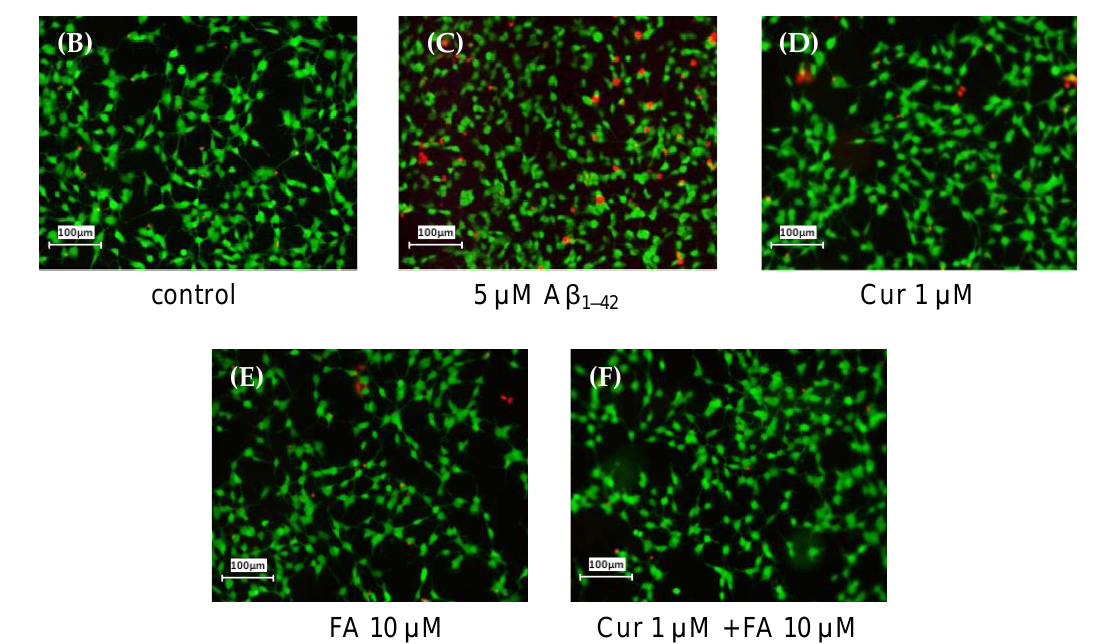
Figure 4. Effect of Cur, FA, or a combination of both on the cytotoxicity in A β 1–42 -stimulated SH-SY5Y cells. The cytotoxicity in A β 1–42 -stimulated SH-SY5Y cells was evaluated using EthD-1 Cell assay. ( A ) The cytotoxicity of SH-SY5Y cells exposed to 5 µ M A β 1–42 and treated with A β 1–42 + 1 µ M Cur, A β 1–42 + 10 µ M FA or A β 1–42 + 1 µ M Cur + FA. ( B – E ) Fluorescence microscopic images in SH-SY5Y cells were acquired using an inverted fluorescence microscope. ( B ) Untreated SH-SY5Y cells; ( C ) SH-SY5Y cells exposed to 5 µ M A β 1–42 ; ( D ) SH-SY5Y cells treated with 5 µ M A β 1–42 + 1 µ M Cur; ( E ) SH-SY5Y cells treated with 5 µ M A β 1–42 + 10 µ M FA; ( F ) SH-SY5Y cells treated with 5 µ M A β 1–42 + 1 µ M Cur + 10 µ M FA. The scale bar represents 100 µ m. +: inclusion of 5 µ M A β 1–42 , 1 µ M Cur, 10 µ M FA, respectively, − : non-inclusion. The p -values in ANOVA were < 0.001. Each value expresses the mean + S.E.M. of at least 3 independent experiments. In the absence of 5 µ M A β 1–42 , cytotoxicity of control, 1 µ M Cur, 10 µ M FA and Cur + FA-treated cells were 10.48 ± 0.52, 10.21 ± 1.54, 10.27 ± 2.06 and 10.30 ± 1.73% (no significant difference, n = 6, Tukey). #, p < 0.0001 for A β 1–42 exposed cells versus the other treated cells (n = 6, Tukey); *, p <0.05 for A β 1–42 + Cur + FA-treated cells versus Cur-treated cells (n = 6,